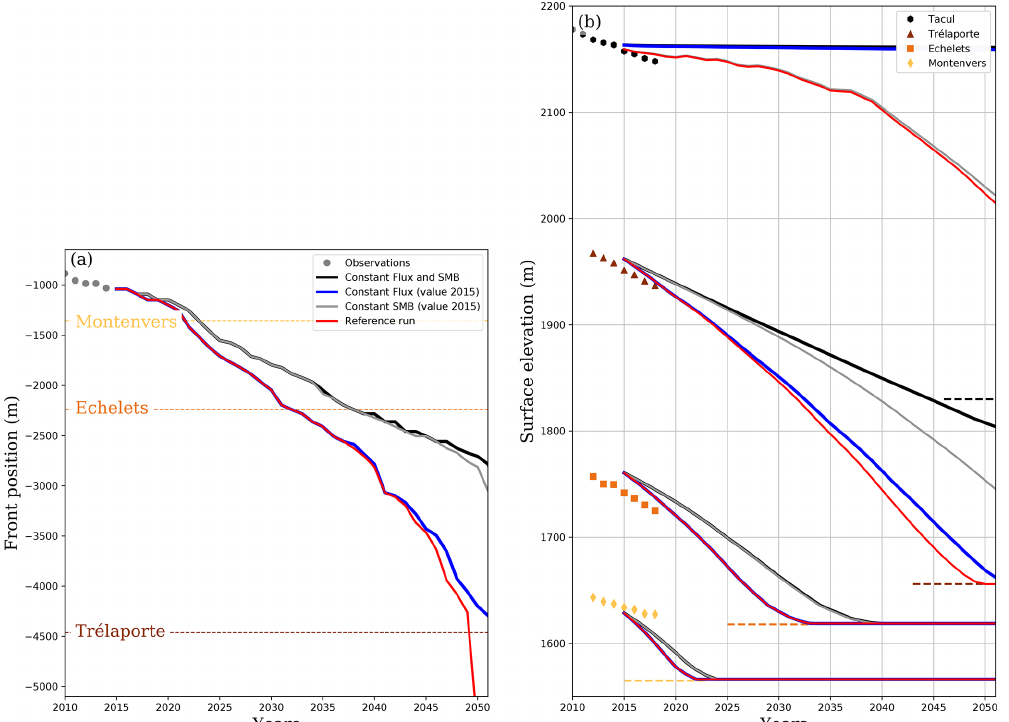
Figure 8. Sensitivity experiment for the mean reference scenario assuming the mean surface mass balance of all scenarios. Evolution of (a) the glacier front and (b) the surface elevation for this mean reference scenarios (red), assuming a constant surface mass balance (gray, value from year 2015), assuming a constant flux at the Tacul gate (blue, value from year 2015) and assuming that both surface mass balance and flux at the Tacul gate are constant and equal to their 2015 values (black). Dashed lines indicate in (a) the position along the retreat line and in (b) the bedrock elevation for the gates. For the two lowest gates of Echelets and Montenvers, the red and blue curves are